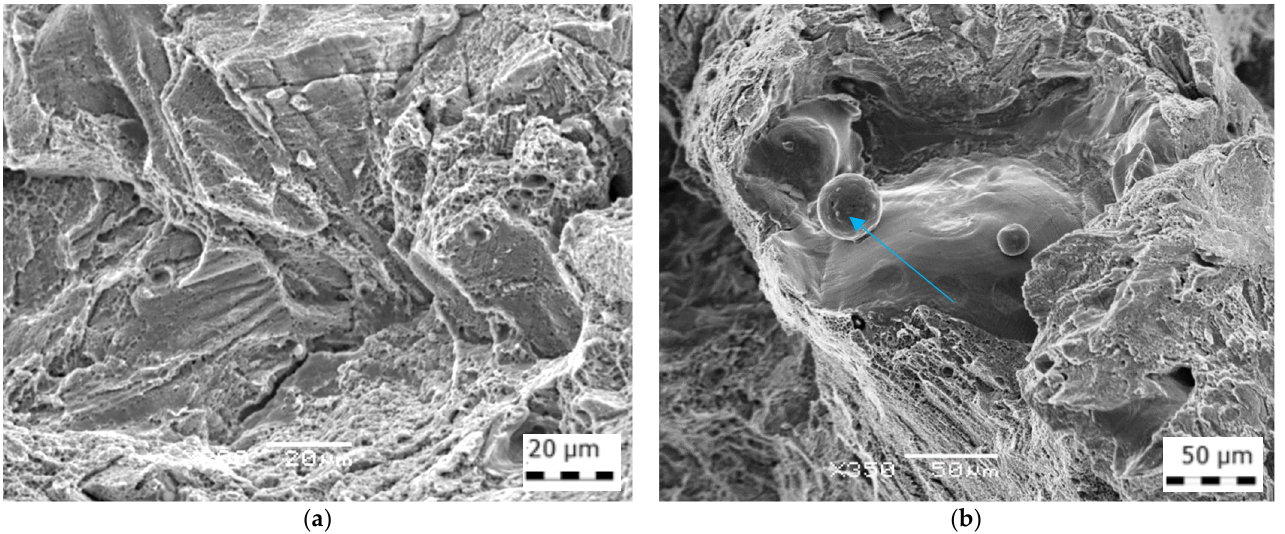
Figure 13. Fracture surface of 3DS Charpy V-notch test: ( a ) combination of the fracture mechanisms; ( b ) defects on the fracture surface, blue arrow shows unmelted metal particle.